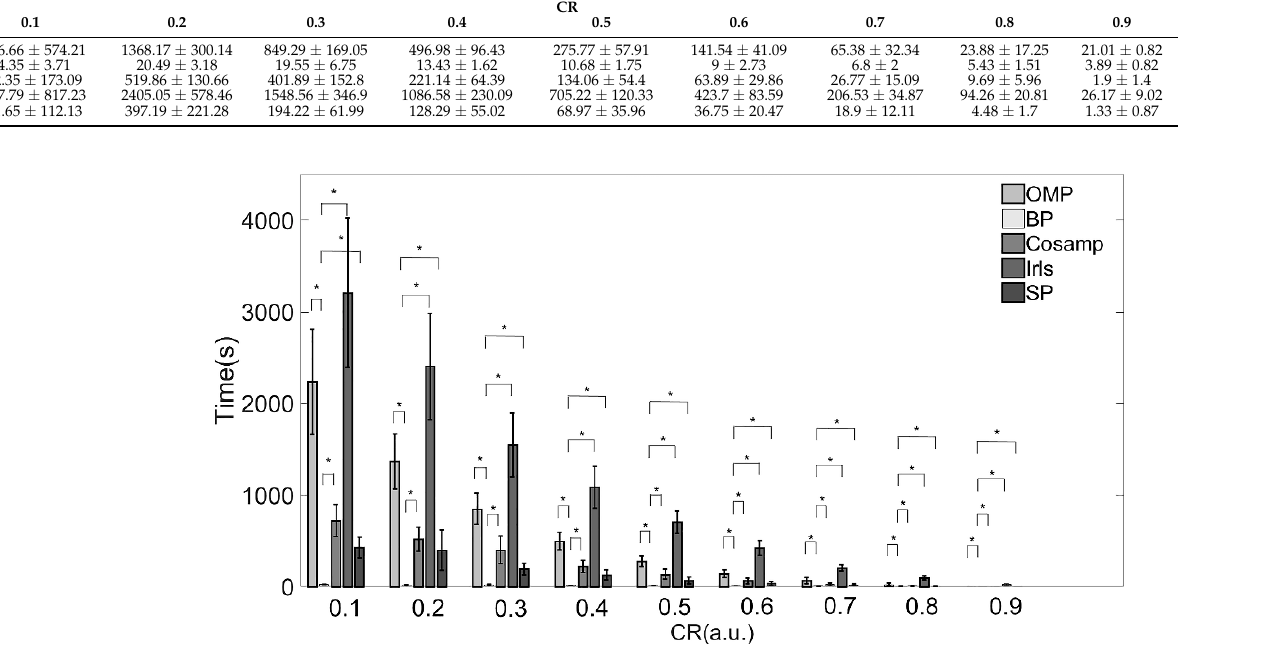
Table 2. PRD values of the reconstruction signals for the different compression ratios (CRs) based on the same wavelet basis. Values are means ± SD.